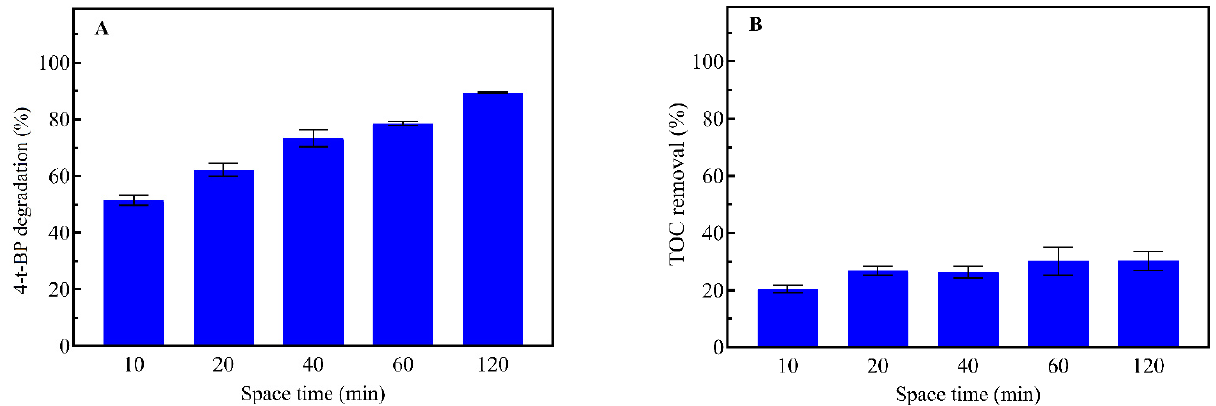
Figure 2. 4-t-BP degradation ( A ) and TOC removal ( B ) as a function of space time in the UV-photolysis.